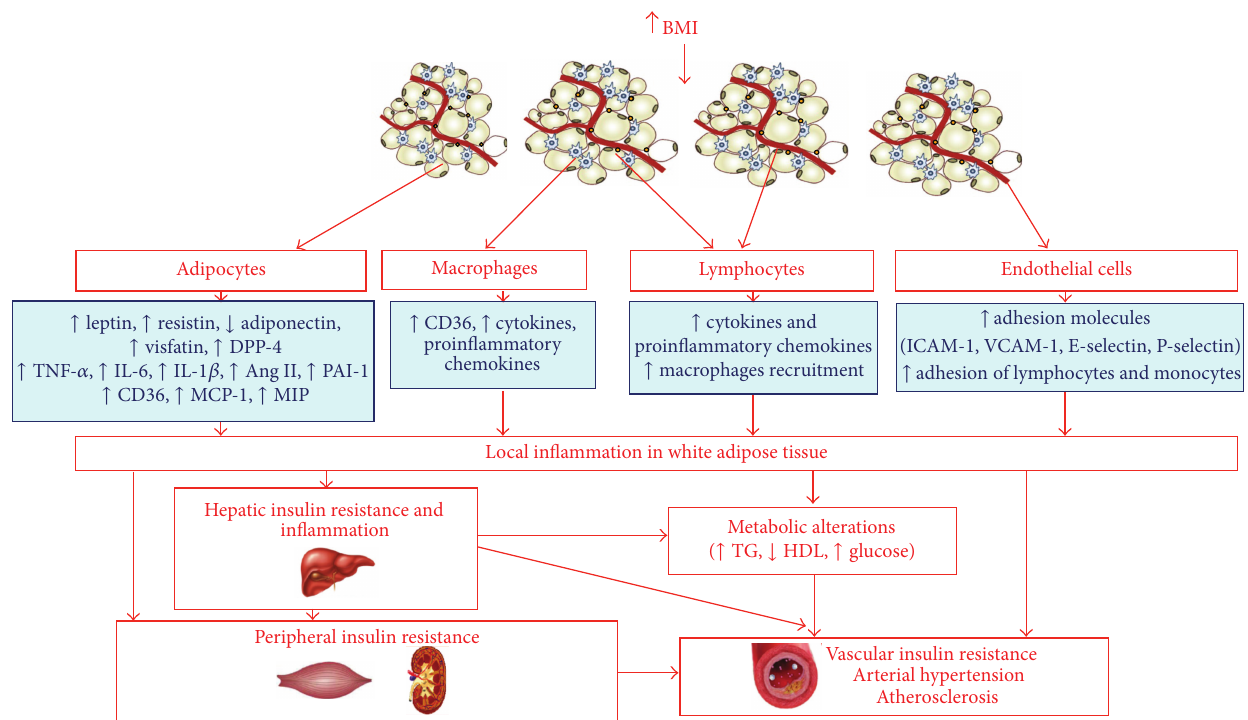
Figure 1: Contribution of white adipose tissue to obesity and its associated metabolic and vascular complications. Obesity is a proinflammatory state of low grade. Adipocytes, infiltrated macrophages, and lymphocytes in addition to endothelial cells from capillaries close to adipocytes contribute to local inflammation in WAT. In obesity an increase of lipid accumulation takes place in adipocytes, triggering cellularstressandtheactivationofJNKandNF- 𝜅 Bpathwaysleadingtolocalinflammationintheadipocyte.Theinflammationcangothrough the portal vein to the liver and finally to other peripheral tissues like vascular tissues where it can produce atherosclerosis, hypertension, and vascular insulin